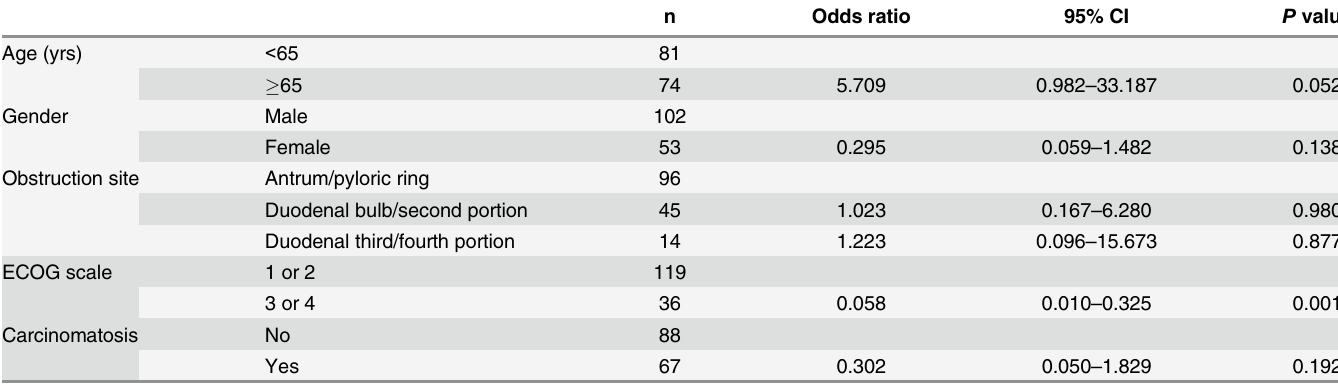
Table 3. Multivariate analysis of factors associated with clinical success of self-expandable metallic stent